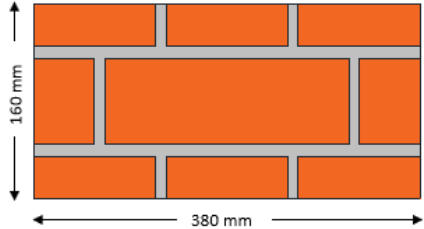
Figure 2. Periodic RVE for the masonry wall.